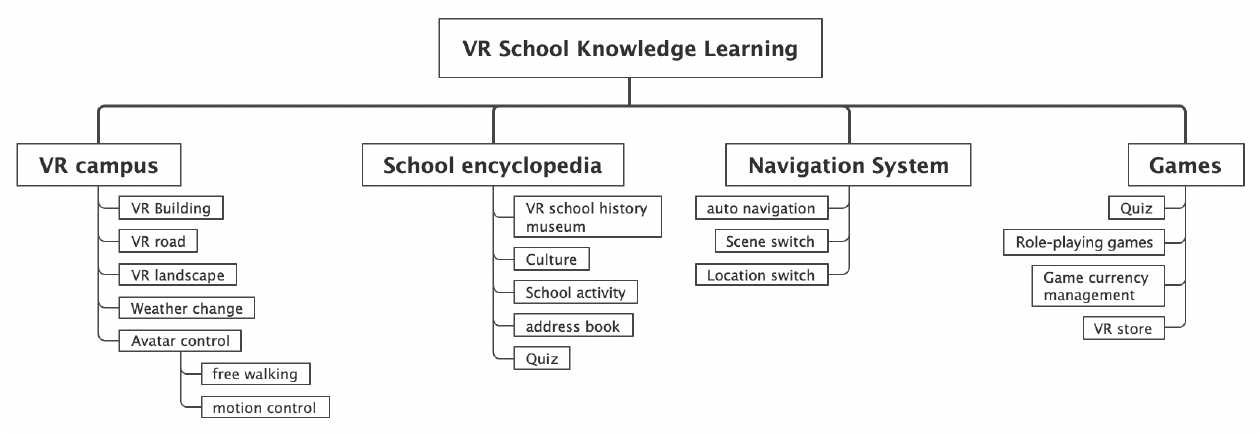
Figure 4. System functional architecture design